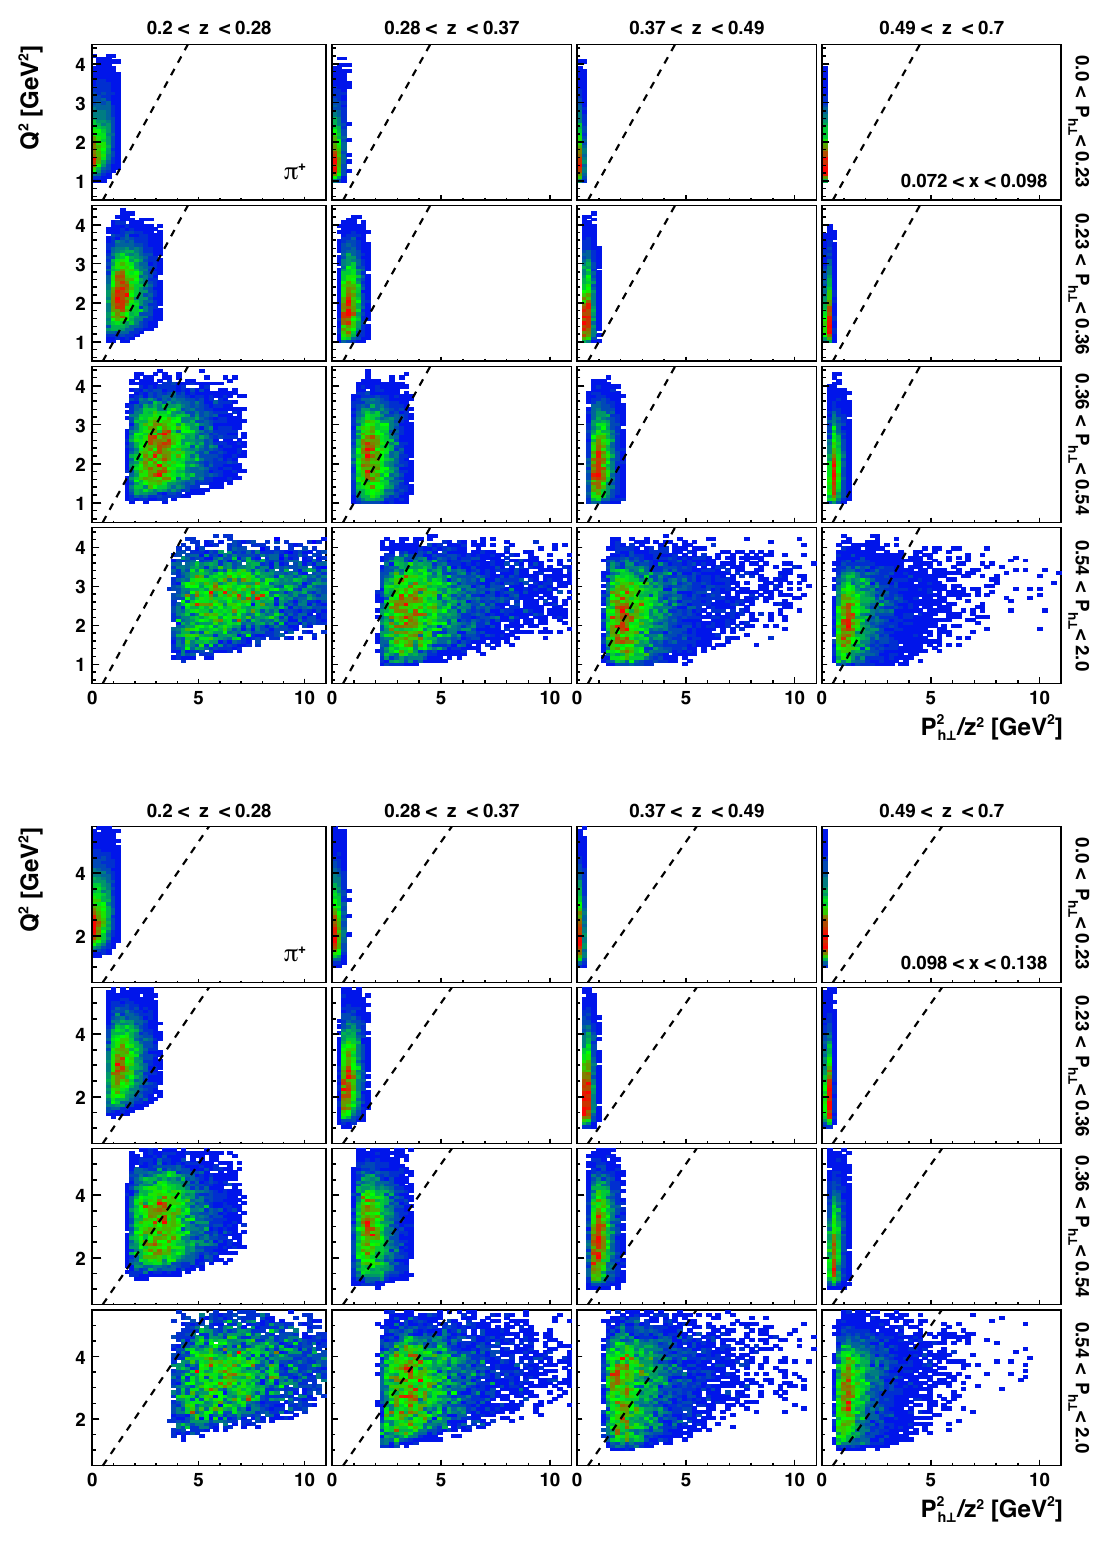
Figure 45 . The distribution of π + events in the Q 2 – P 2 the second (top) and third (bottom) x bin. The Q 2 = P 2